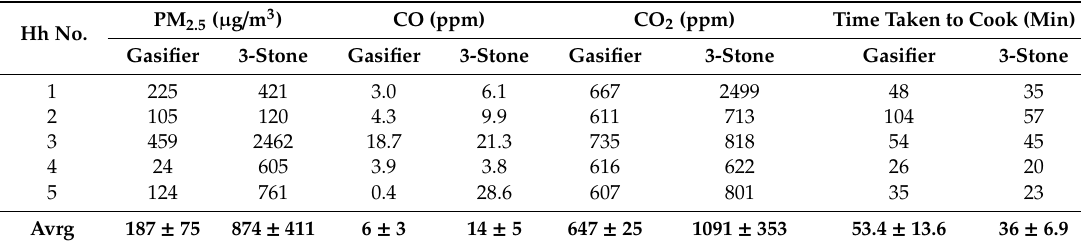
Table 6. Concentrations during cooking with gasifier and 3-stone open fire.